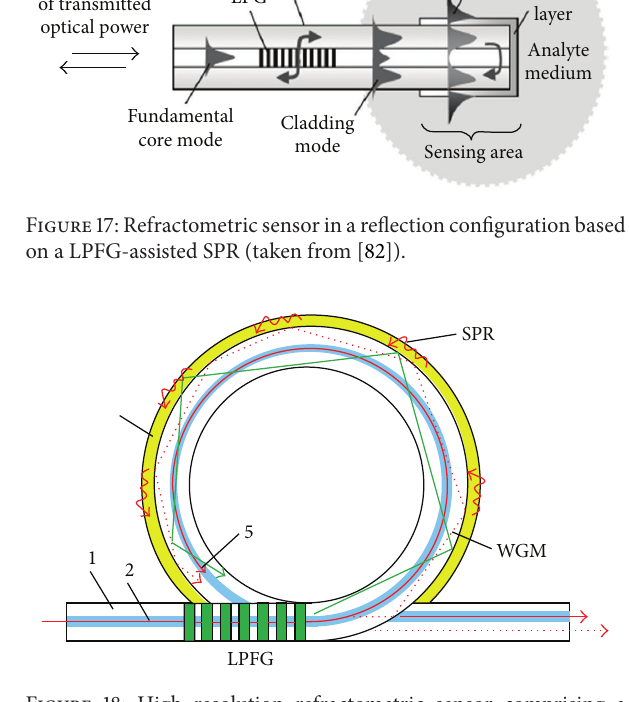
Figure 18: High resolution refractometric sensor comprising a LPFG, a WGM, and SPR (adapted from